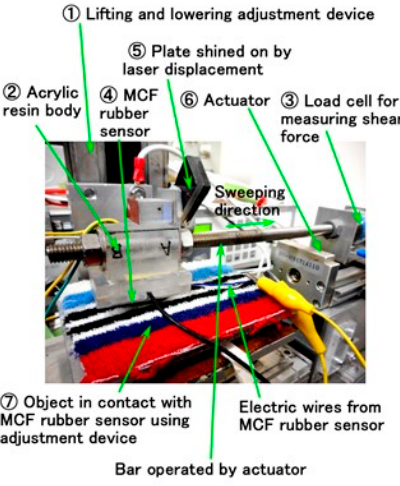
Figure 2. Image of experimental apparatus used to investigate the electrical property in the case of the shear force experiment (SFE).